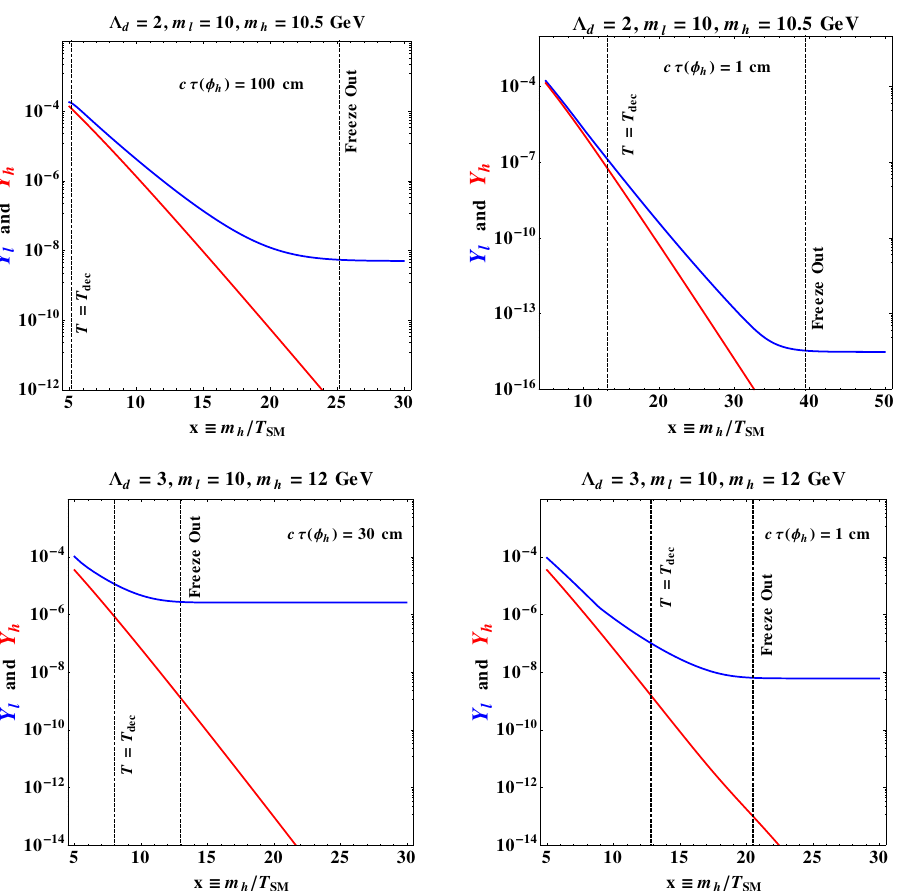
Figure 2 . Evolution of Y l;h in x (cid:17) m h =T SM for di(cid:11)erent dark hadron masses and (cid:30) h lifetimes. The blue and red curves stand for Y l and Y h separately. The vertical lines at smaller x values show the temperature of thermal decoupling between the hidden and SM sectors. The vertical lines at larger x values show the temperature of (cid:17) d freeze out. We assume Y h = Y l for the initial condition.